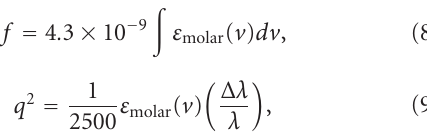
Table 3: Values of energy gaps of PTCDI thin films according to the band transition. Transport gap “HOMO-LOMO gap” Onset gap PTCDI As deposited 2 . 68 ± 0 . 01